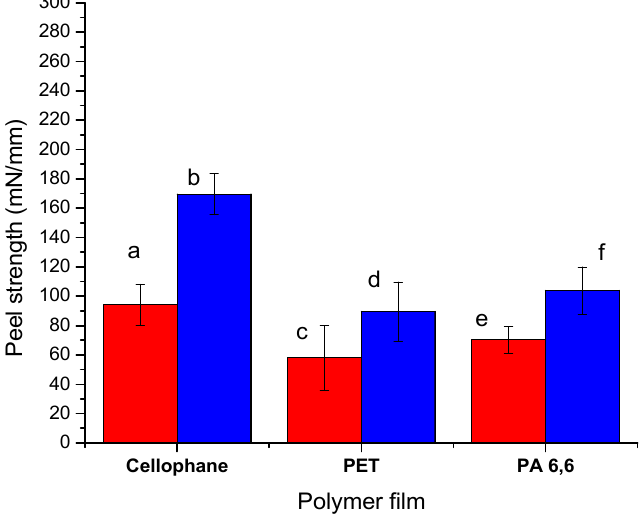
Figure 8. Peel strength for polymer films made of cellophane, PET, and PA 6,6 adhered with ( a , c , e ) NFC and ( b , d , f ) NCC.